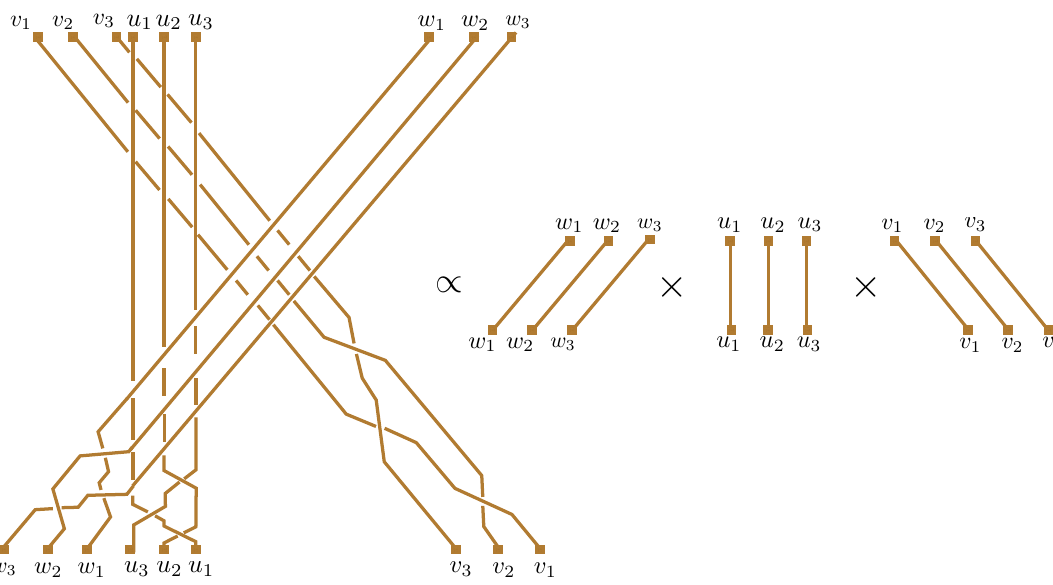
Figure 7 . When the incoming state are fermions with parallel polarizations, the vertex becomes proportional to the identity, e.g. R happens at all vertices if L factors times the inner product between incoming and outgoing polarizations, equation (2.20). Of course, the same simplification holds if instead we have R